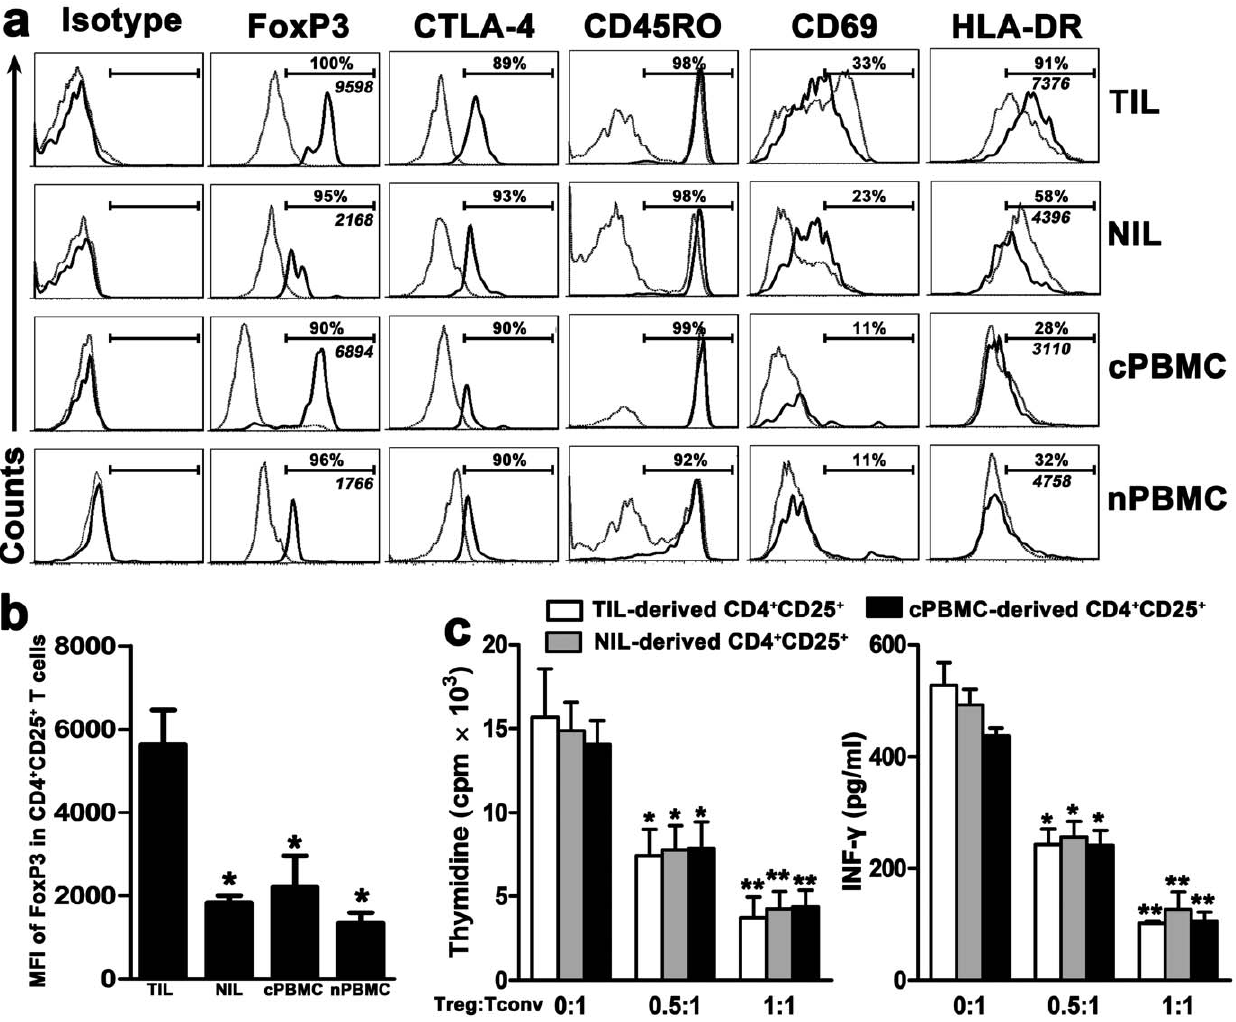
Figure 2. Phenotypic and functional analysis of CD4 + CD25 + Tregs in HCC patients. ( a ) Representative FoxP3, CTLA-4, CD45RO, CD69 and HLA-DR expression profiles in CD4 + CD25 + (thick line) and CD4 + CD25 2 (dotted line) T cells from the four studied groups. Specific isotypes were used as negative control. The percentages represent the frequencies of various markers on CD4 + CD25 + T cells. The italic numerical values represent MFI of FoxP3 in CD4 + CD25 + T cells. (b) Statistical analysis shows that the MFI of FoxP3 in CD4 + CD25 + T cells from TIL was significantly higher than those from NIL, cPBMC, and nPBMC. * P , 0.05, compared with TIL. (c) Purified CD4 + CD25 + T cells (Tregs) from TIL, NIL, and cPBMC could similarly inhibit the proliferation and INF- c production of autologous CD4 + CD25 2 T cells (Tconv) in a dose-dependent manner (n=3 for each group). * P , 0.05; ** P , 0.01, compared with autologous controls (Treg:Tconv=0:1). Data in (b) and (c) represent the mean 6 S.E.M. doi:10.1371/journal.pone.0024671.g002 P = 0.012) (Figure 6). Using multivariable analysis, tumor FoxP3 +